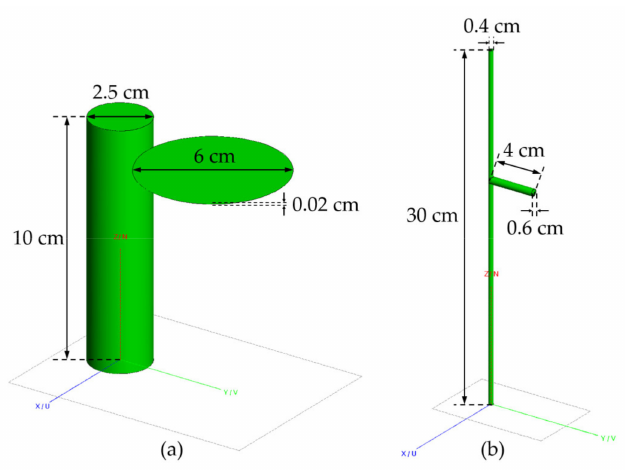
Figure 5. Two different structures of vegetation canopy components: ( a ) the component structure of canopy A; ( b ) the component structure of canopy